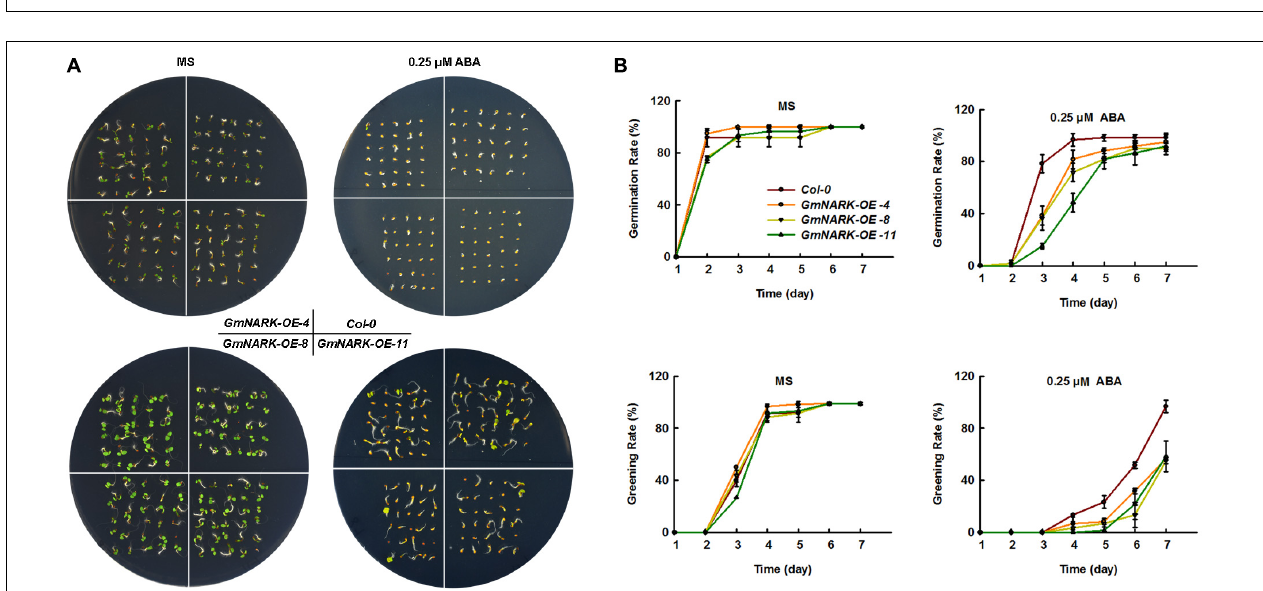
FIGURE 7 | Overexpression of GmNARK increased salt stress sensitivity of transgenic Arabidopsis during germination and greening. (A) Phenotypic analysis of Col-0 , GmNARK-OE-4 , GmNARK-OE-8, and GmNARK-OE-11 treated with 150 mM NaCl. The up panel is the germination images of 3-day-old seeds and the bottom panel is the greening images of 7-day-old seeds. (B) The germination rates and greening rates of Col-0 , GmNARK-OE-4 , GmNARK-OE-8, and GmNARK-OE-11 under 150 mM NaCl treatment. The data were given as means plus the standard deviation of three independent replicates.